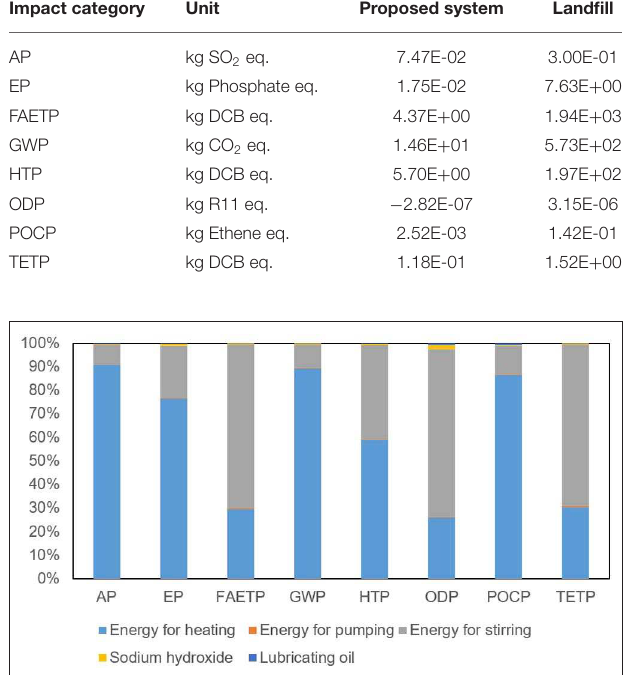
TABLE 4 | Comparison of proposed food waste treatment system and landfill option. Impact category